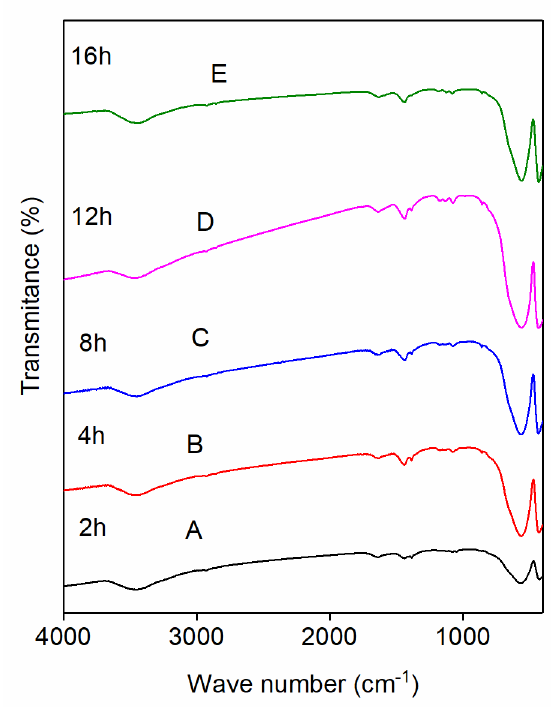
Figure 6. Typical FT-IR spectra of the BaTiO 3 nanocrystals obtained by hydrothermally treating at 210 °C for various times (2–16 h) with R Ba/Ti = 2.0 and [NaOH]=2.0 mol L −1 .